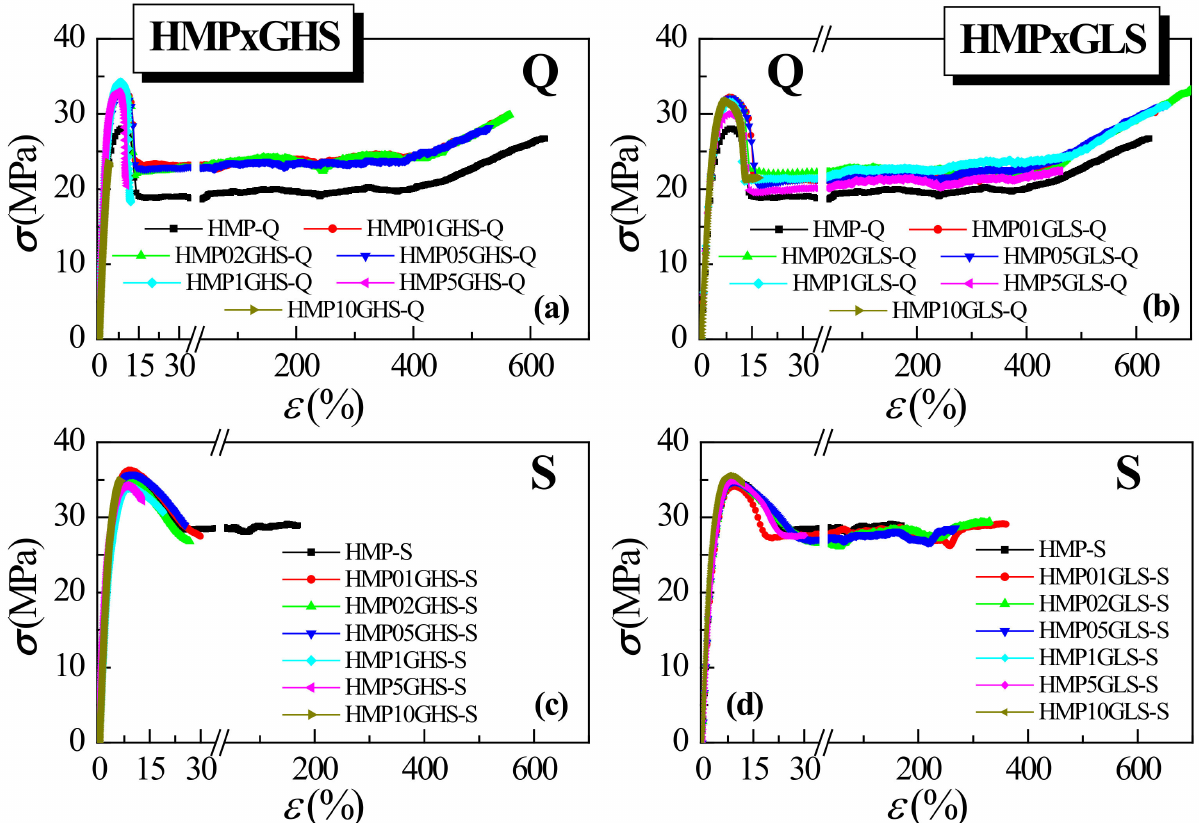
Figure 8. Stress-strain curves for the metallocene iPP matrix and nanocomposites with different contents and types of graphene nanofibers: ( a ) HMP x GHS family with Q treatment; ( b ) HMP x GLS family with Q treatment; ( c ) HMP x GHS family with S treatment; and ( d ) HMP x GLS family with S